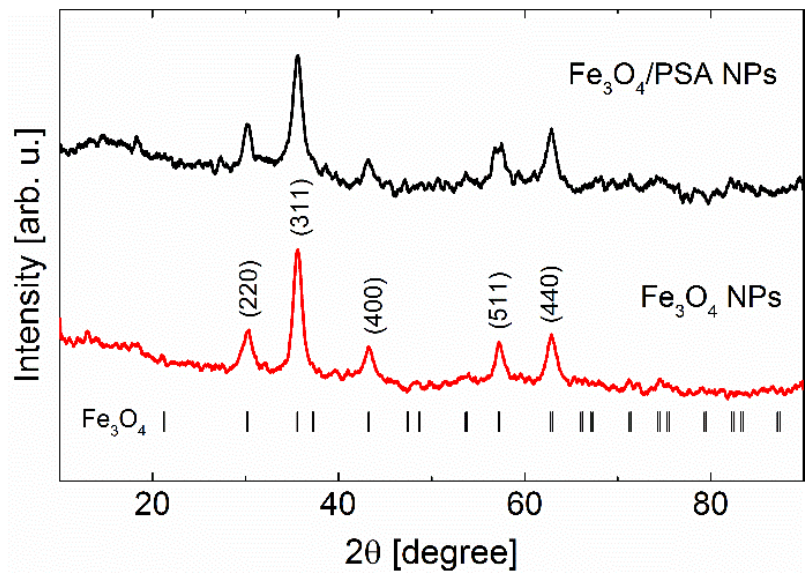
Figure 1. X-ray diffraction patterns of Fe 3 O 4 /PSA NPs and Fe 3 O 4 NPs samples. The ticks at the bottom indicate the positions of the Bragg reflections for Fe 3 O 4 cubic phase. The most pronounced peaks were described by Miller indices.